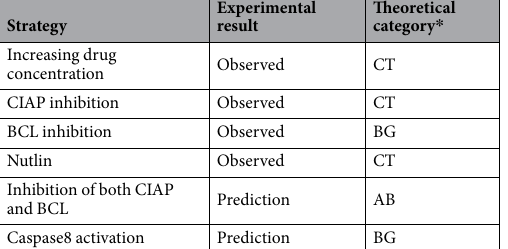
Table 2. List of strategies that combat fractional killing. * Three categories: 1. BG- alteration of bifurcation geometry; 2. CT- alteration of cellular trajectory; 3. AB- alteration of both bifurcation geometry and cellular